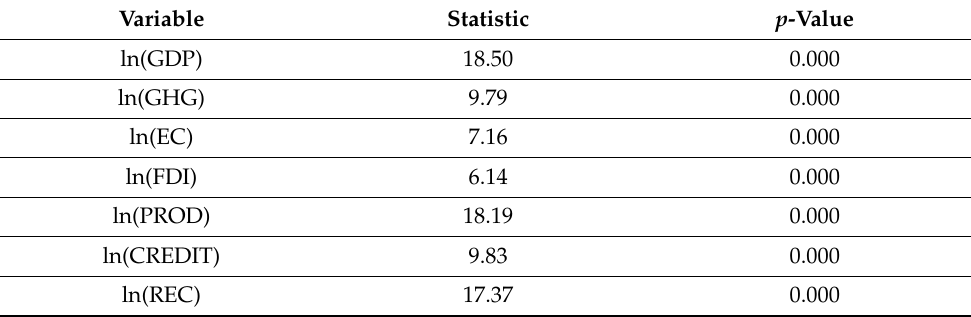
Table 4. The results of CD Pesaran’s test for cross-sectional dependence (1996–2019). Variable